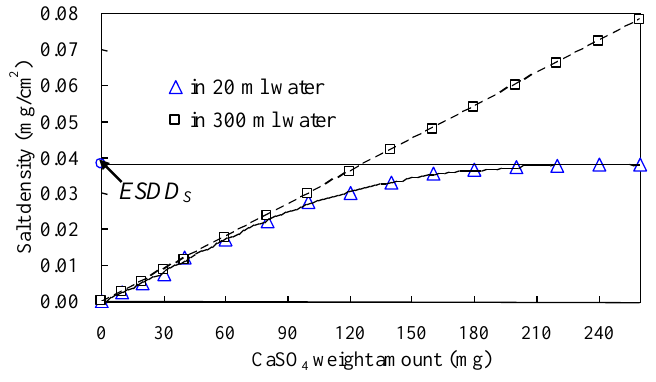
Figure 5. The ESDD contribution of CaSO 4 , considering different amounts of water.